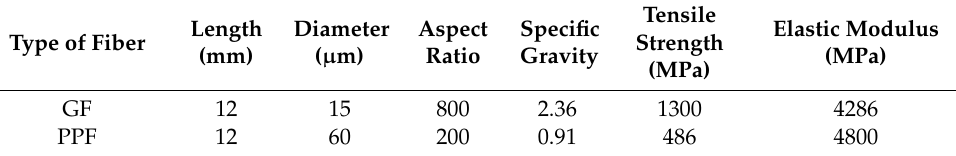
Figure 1. Appearance of the used fibers: ( a ) GF and ( b ) PPF.